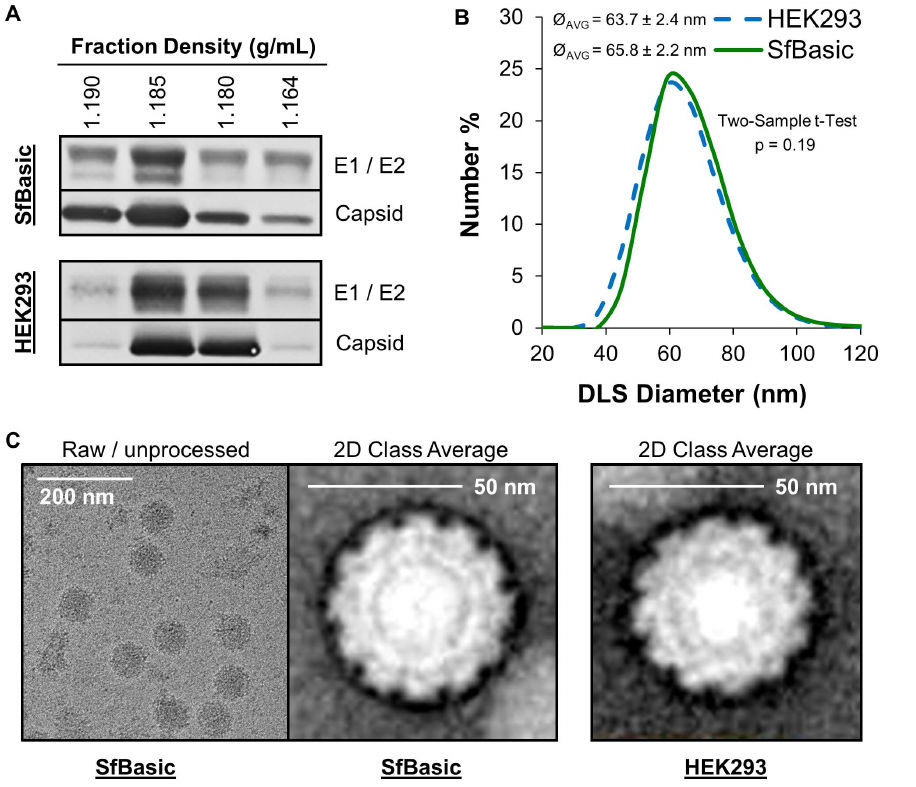
Figure 6. Biophysical characterization of CHIKV VLPs derived from SfBasic cells and comparison to a VLP standard derived from HEK293 cells. ( A ) Western blot of density gradient ultracentrifugation fractions containing CHIKV VLPs, using E1, E2, and capsid peptide-specific antibodies. ( B ) Dynamic light scattering (DLS) distribution of purified CHIKV VLP diameters (Ø). ( C ) Raw/unprocessed and 2D class average transmission electron microscopy images of purified CHIKV VLPs.